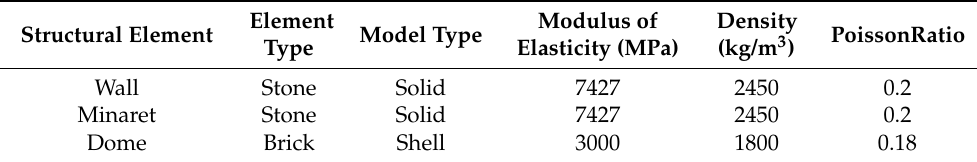
Table 2. Material properties used in the model (Celik and Gaye, 2016; Aslan and Aslan, 2016). Structural